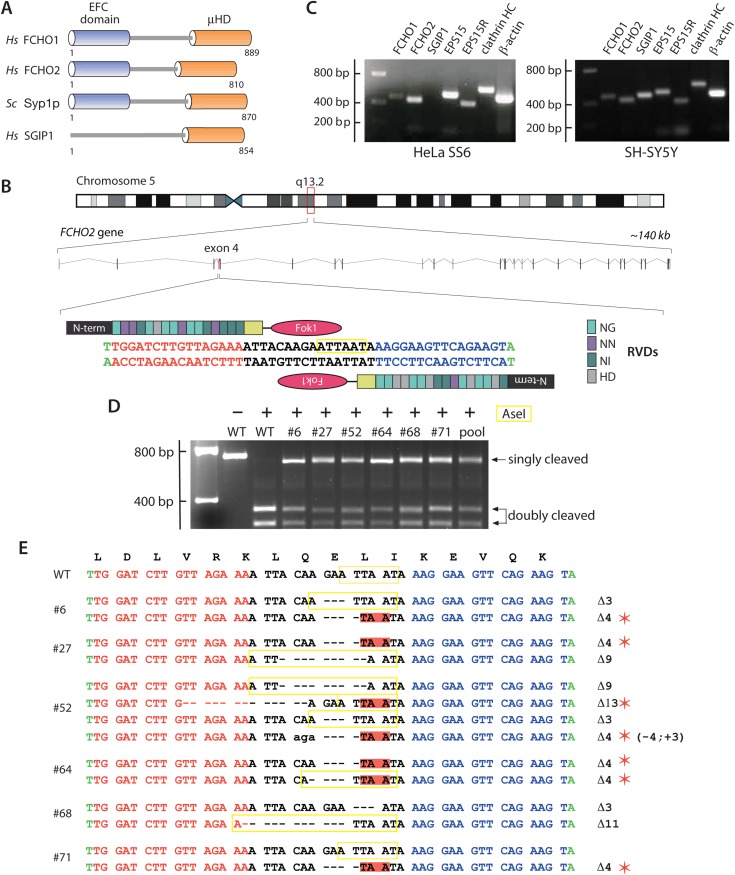
Gene editing the FCHO2 locus in HeLa cells.(A) Domain arrangement of Homo sapiens (Hs) and S. cerevisiae (Sc) muniscin family proteins. The crescent-shaped EFC domain (Extended FCH (Fer/Cip4 homology) domain) is alternatively designated the F-BAR domain due to an overall structural homology of the α-helical anti-parallel EFC dimer to the BAR (Bin1/amphiphisin/Rvs) domain family of proteins. (B) Chromosomal location and genomic organization of the FCHO2 gene with pertinent details of TALEN design. The repeat variable di-residues (RVD) selective for the different deoxyribonucleotides are color-coded (single letter amino acid notation). The endogenous AseI recognition sequence within the targeted exon is boxed (yellow). (C) Gene-specific RT-PCR analysis of various endocytic protein and control mRNA transcripts in the parental HeLa SS6 and neuroblastoma SH-SY5Y cells. HC; heavy chain. (D) AseI restriction enzyme digestion of FCHO2 gene-specific PCR amplicons from genomic DNA extracted from wild-type (WT) and TALEN-treated clones. The undigested parental (HeLa) PCR product and digested PCRs are shown. The ‘pool’ designates a PCR reaction from a genomic DNA sample of TALEN-transfetced HeLa cells prior to clone selection. The AseI nuclease generates three PCR DNA fragments; the 55-bp band is not visible on these gels but causes the shift in the singly-cleaved product to 645 bp. (E) Genomic sequence analysis of TALEN clones. TALEN generated insertions (lower case letters) and deletions are indicated in relation to the WT nucleotide and amino acid sequences. AseI restriction sites are boxed (yellow) and in-frame stop codons are highlighted (red) and identified with a red asterisk.